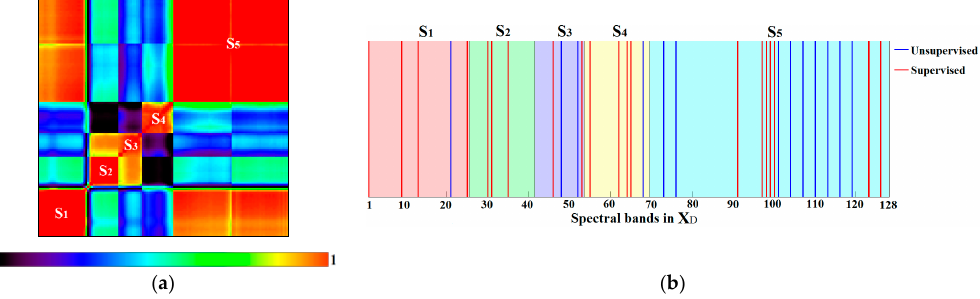
Figure 5. ( a ) The R 2 correlation matrix of X D image, where five highly correlated adjacent band groups are highlighted as S 1 –S 5 ; ( b ) the first 20 selected bands and their corresponding positions in each group (Yancheng dataset).